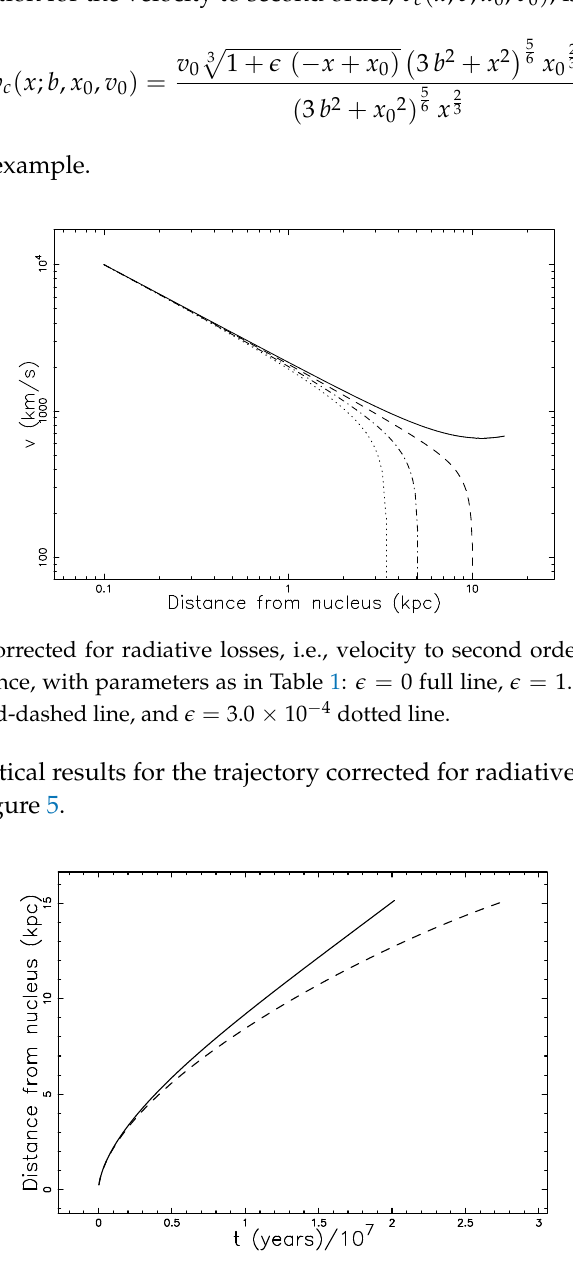
Figure 5. Numerical trajectory corrected for radiative losses as a function of time, with parameters as in Table 1: (cid:101) = 0 full line and (cid:101) = 8.0 × 10 − 5 dashed